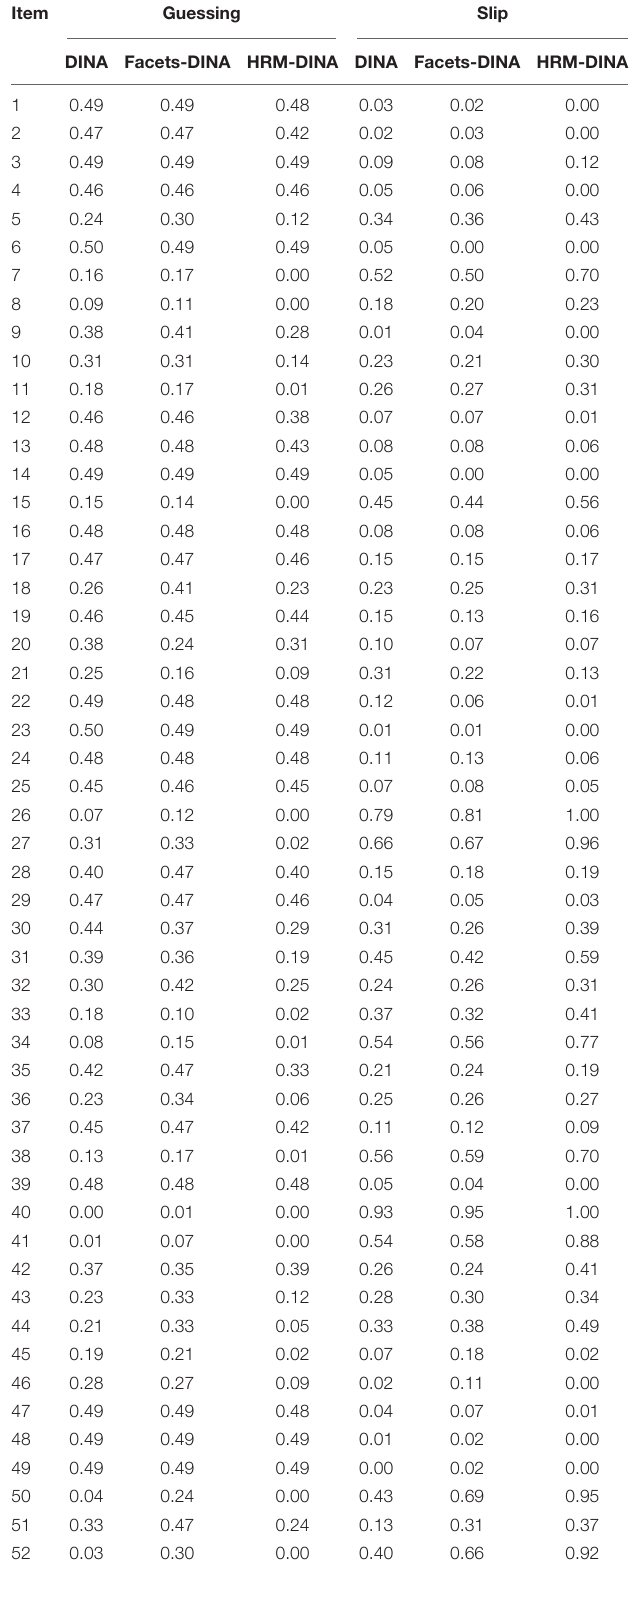
TABLE 7 | Estimates for the guessing and slip parameters yielded by the three models in the empirical example. Item Guessing